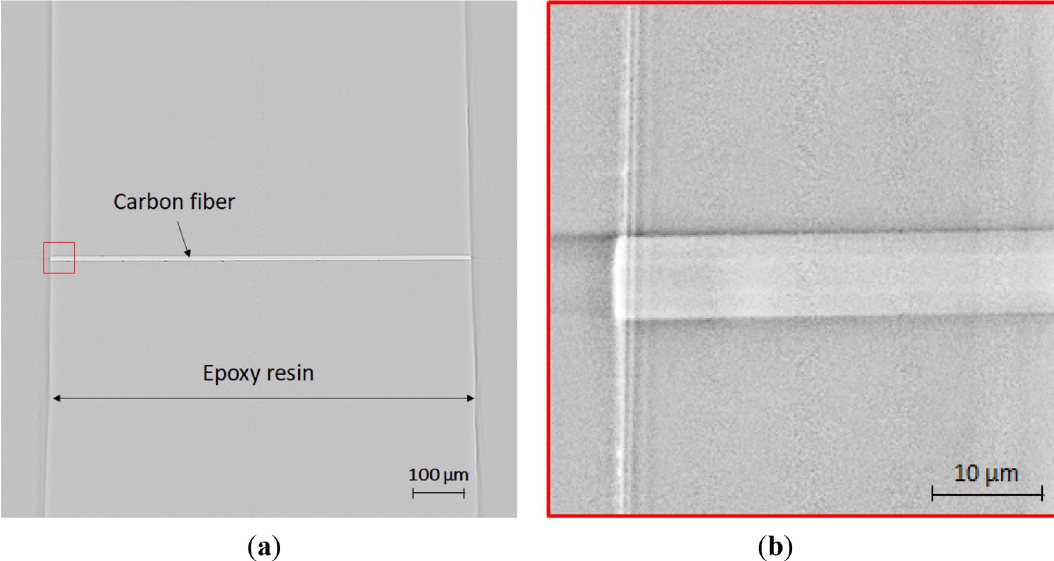
Figure 4. Reconstructed images along the longitudinal cross-section by ( a ) micro-CT and ( b ) nano-CT. The carbon fiber was entirely captured by micro-CT and then focused by nano-CT in the red